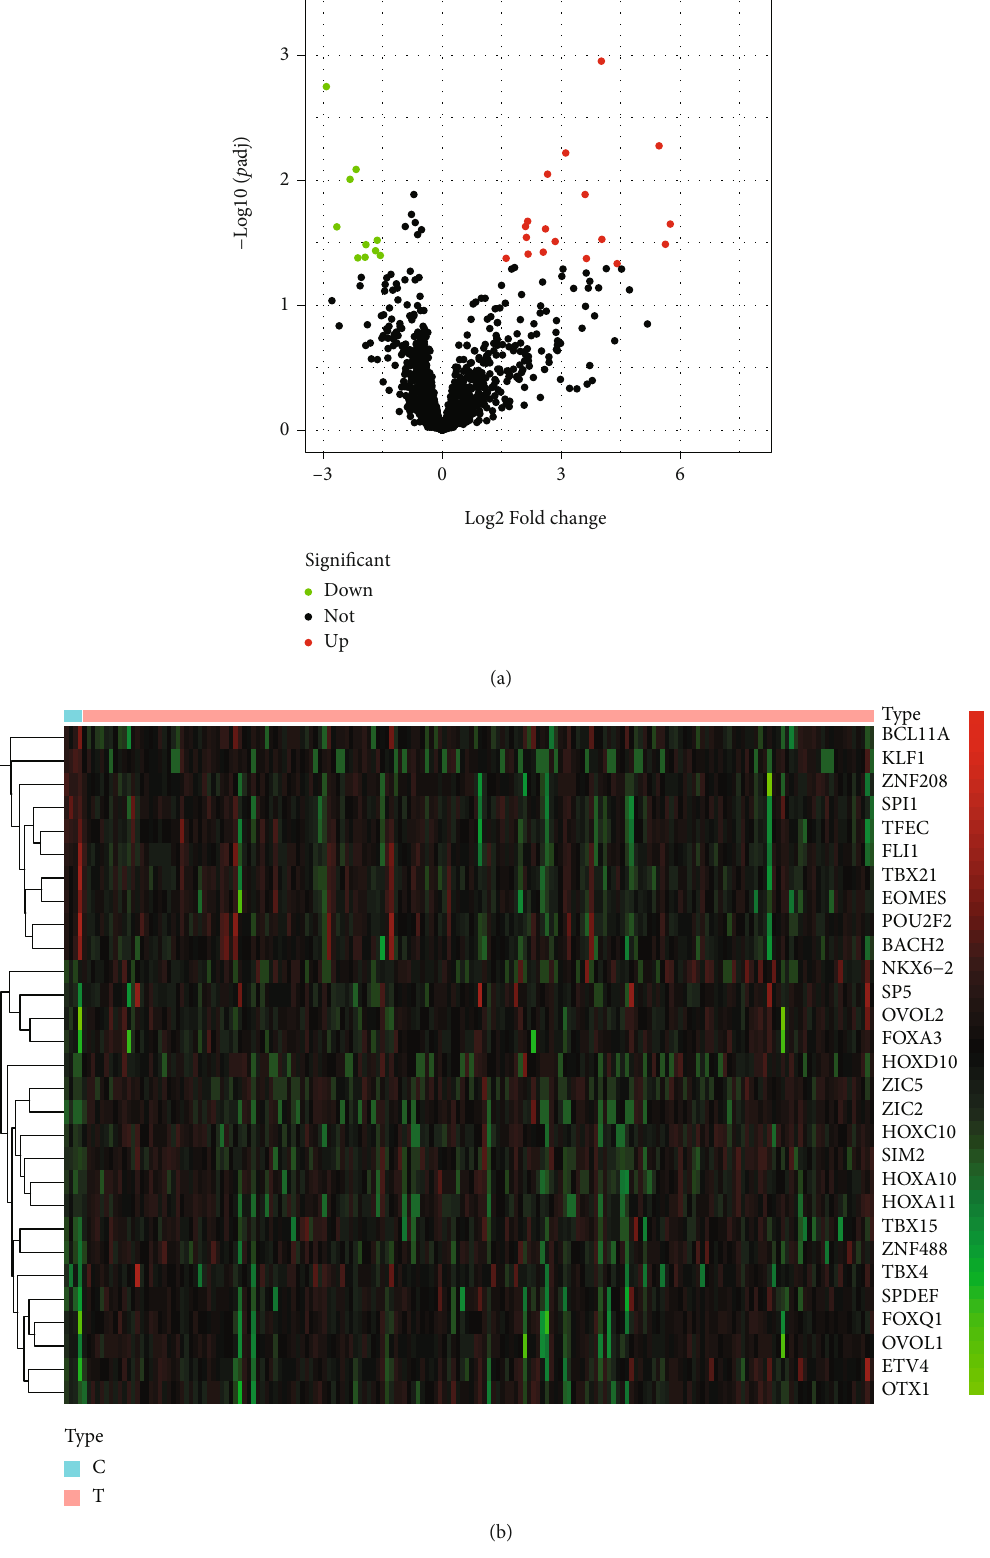
Figure 1: Identi fi cation of the dysregulated TFs in PAAD patients. (a) Volcano plot of upregulated and downregulated TFs. (b) The dysregulated TFs are showed in the heat